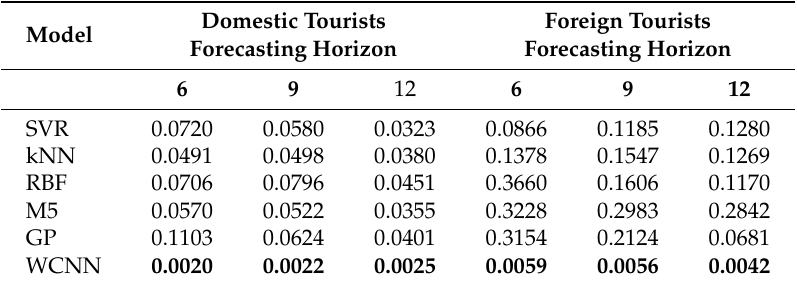
Table 3. Performance comparison based on MAE of WCNN against the state-of-the-art machine learning regression algorithms.